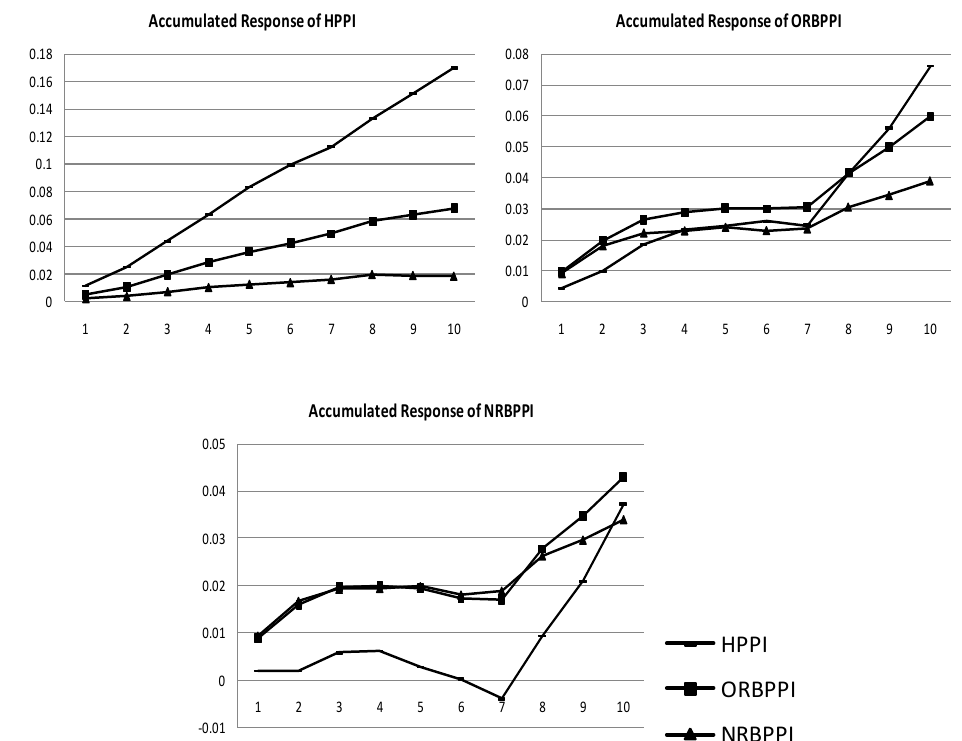
Figure 5: Accumulated response of HPPI, ORBPPI, and